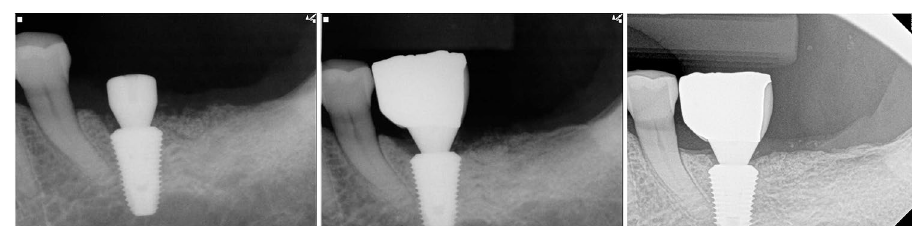
Figure 4. Less than 1 mm distance from the root (Group III); (left) At the time of implant surgery, February 2013; (center) December 2013; (right) tooth remained vital during 7-year functions, May